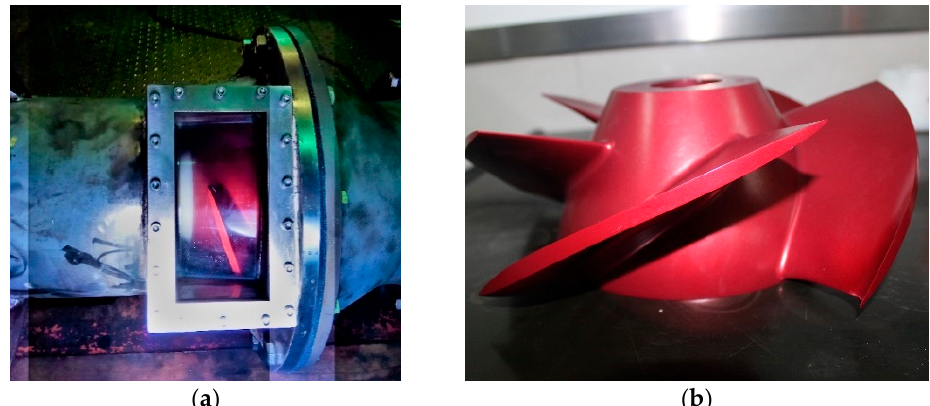
Figure 3. Real hydraulic components of the water-jet pump [3]. ( a ) Assembly and ( b ) impeller.